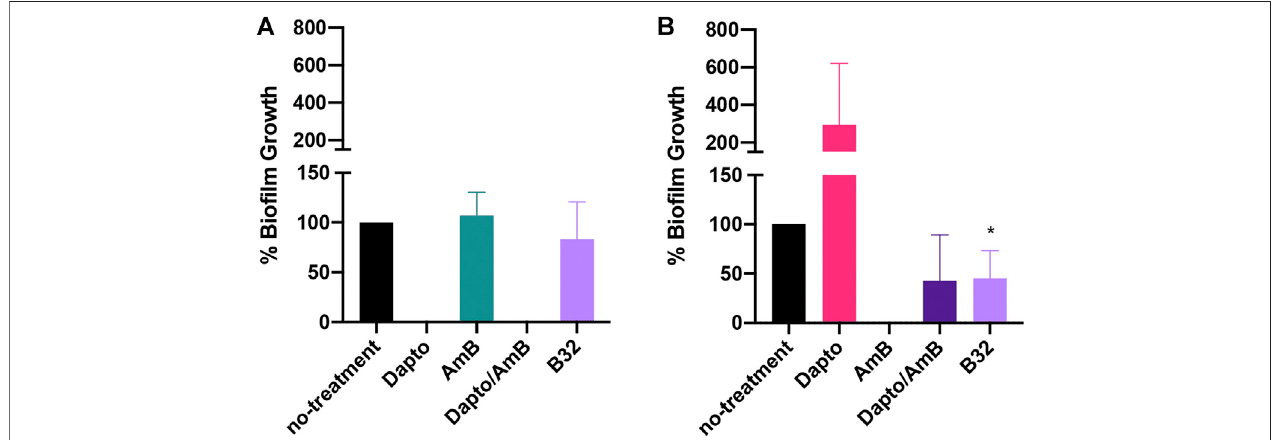
FIGURE8| Bay 11-7085 inhibits C. albicans but not S.aureus growth inamultispecies Lubbock chronic woundmodel. (A) S.aureus strain VRS1 percent growth after treatment with Bay 11-7085 at 8 μ g/ml (B8), 16 μ g/ml (B16), or 32 μ g/ml (B32) for 24 h. Treatment with 8 × daptomycin (8 μ g/ml, Dapto), 16 × amphotericin B (16 μ g/ml, AmB), or a combination of 8 × daptomycin and 16 × amphotericin B (Dapto/AmB) where used as controls. (B) C. albicans percentgrowth after treatment with Bay 11-7085 for 24 h. Statistical signi fi cance was determined using Unpaired t -test. * p < 0.05. ( n (cid:2) 3, ± S.D.).